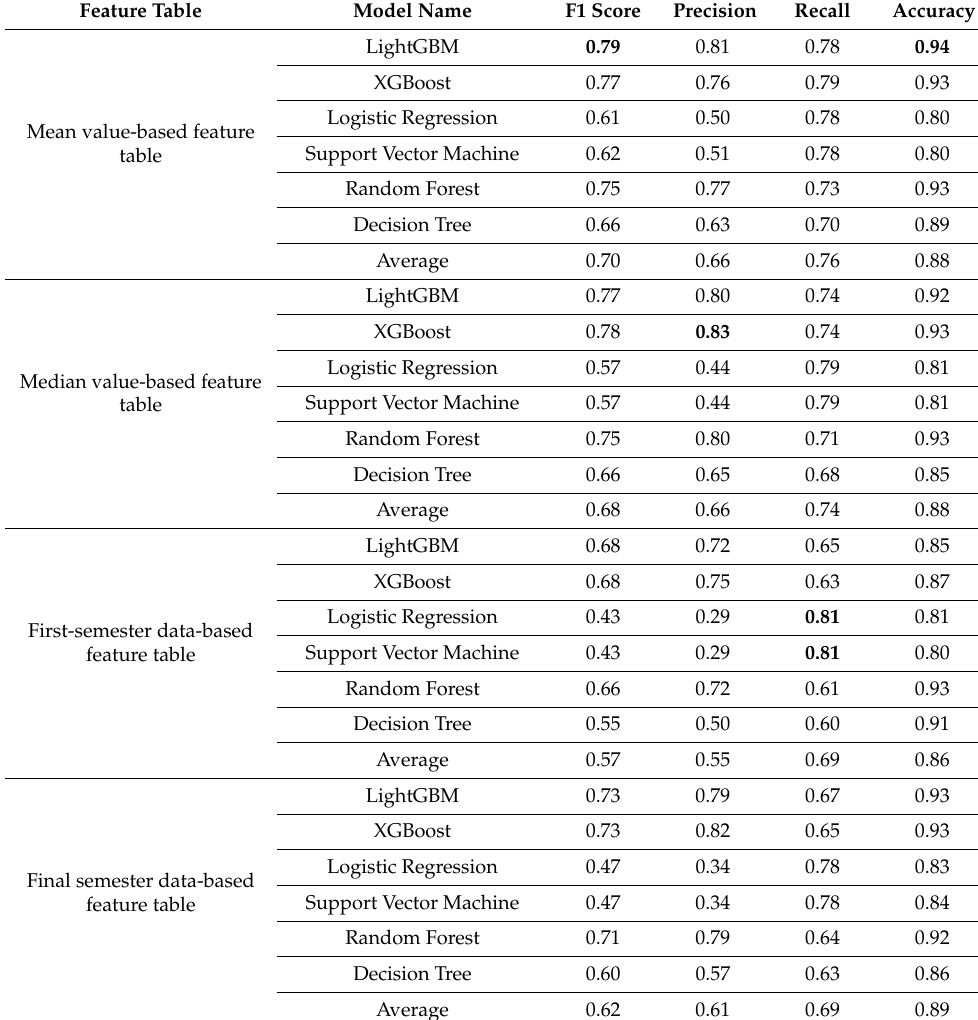
Table 5. F1 Score, Precision, Recall, and Accuracy for class dropout in the test